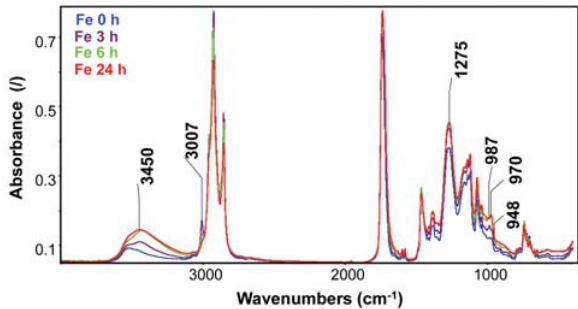
Figure 3. FT-IR spectra of HS alkyd coatings with Fe surface driers versus